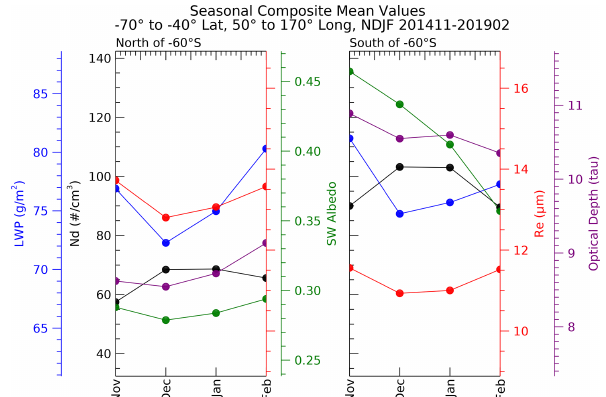
Figure 5. Composite seasonal cycle of cloud properties. Each data point is comprised of the monthly mean of cloud scenes in the anal- ysis domain compiled from November 2014–February 2019. The effective radius (Re, red curve) and the optical depth (solid purple curve) are taken directly from MODIS Level 2 retrievals. The liquid water path (LWP, blue curve) and cloud droplet number ( N d , black curve) are derived as described in the text. The solar (SW) albedo (green curve) is derived from CERES data and normalized to a solar zenith angle of 45 ◦ as described in the